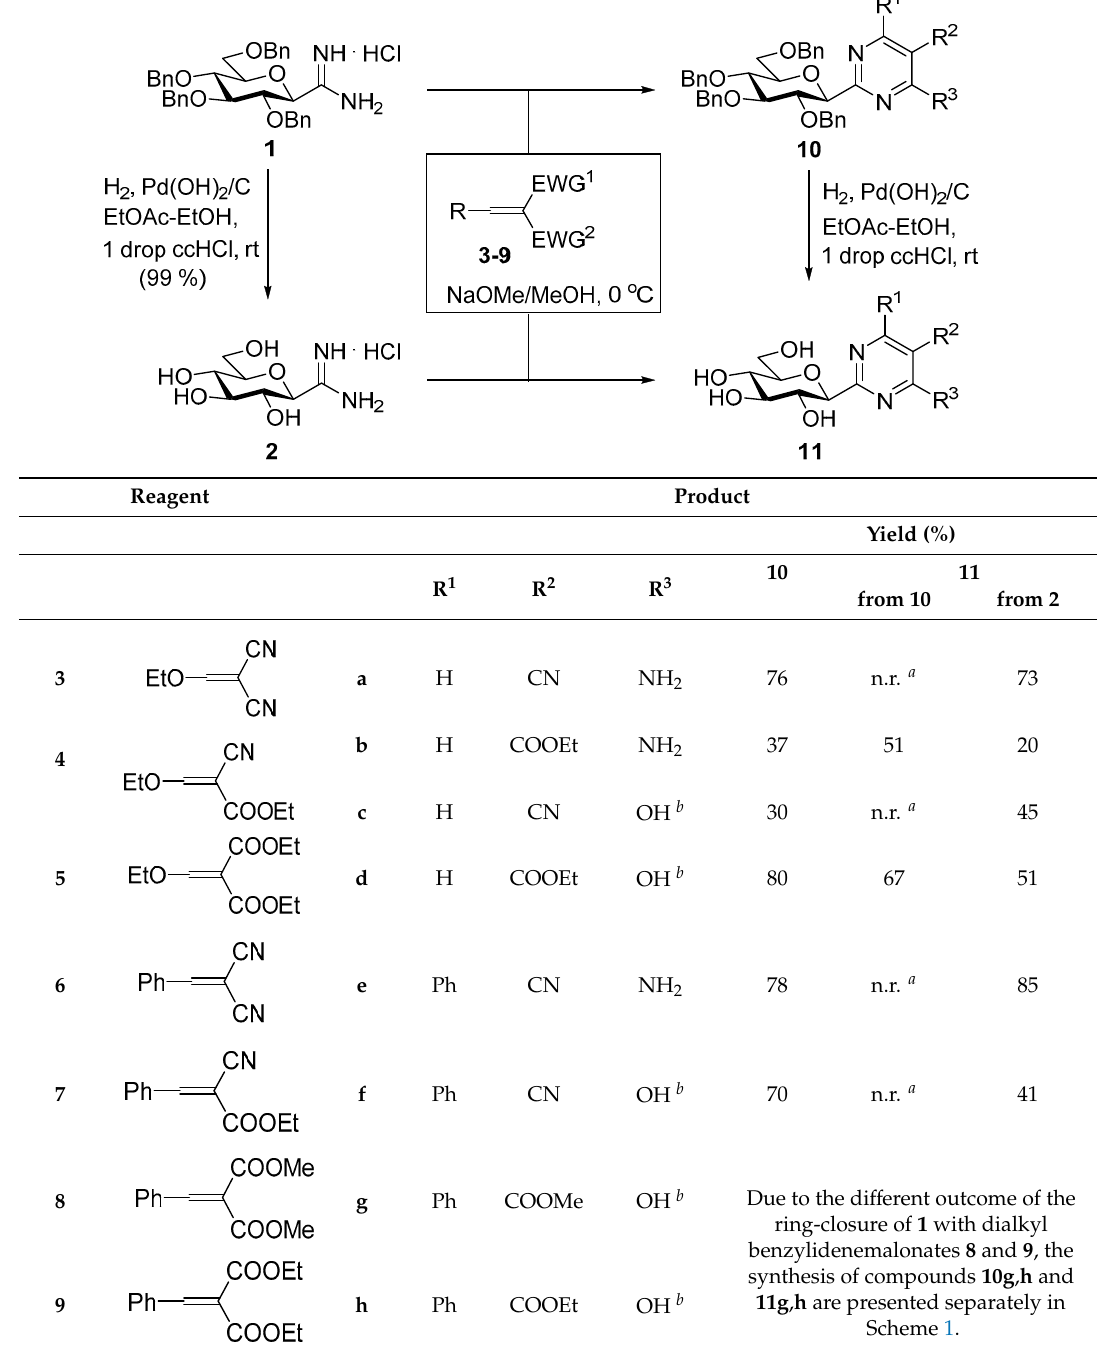
Table 1. Ring-closure of C -( β - D -glucopyranosyl)formamidines with methylenemalonic acid derivatives.